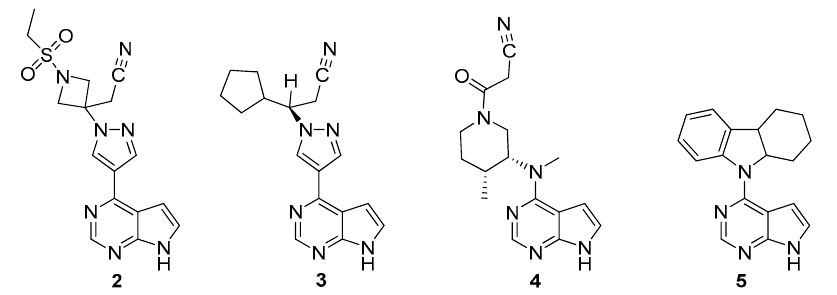
Figure 2. Structure of Janus kinases (JAK) inhibitors 2 – 5 .